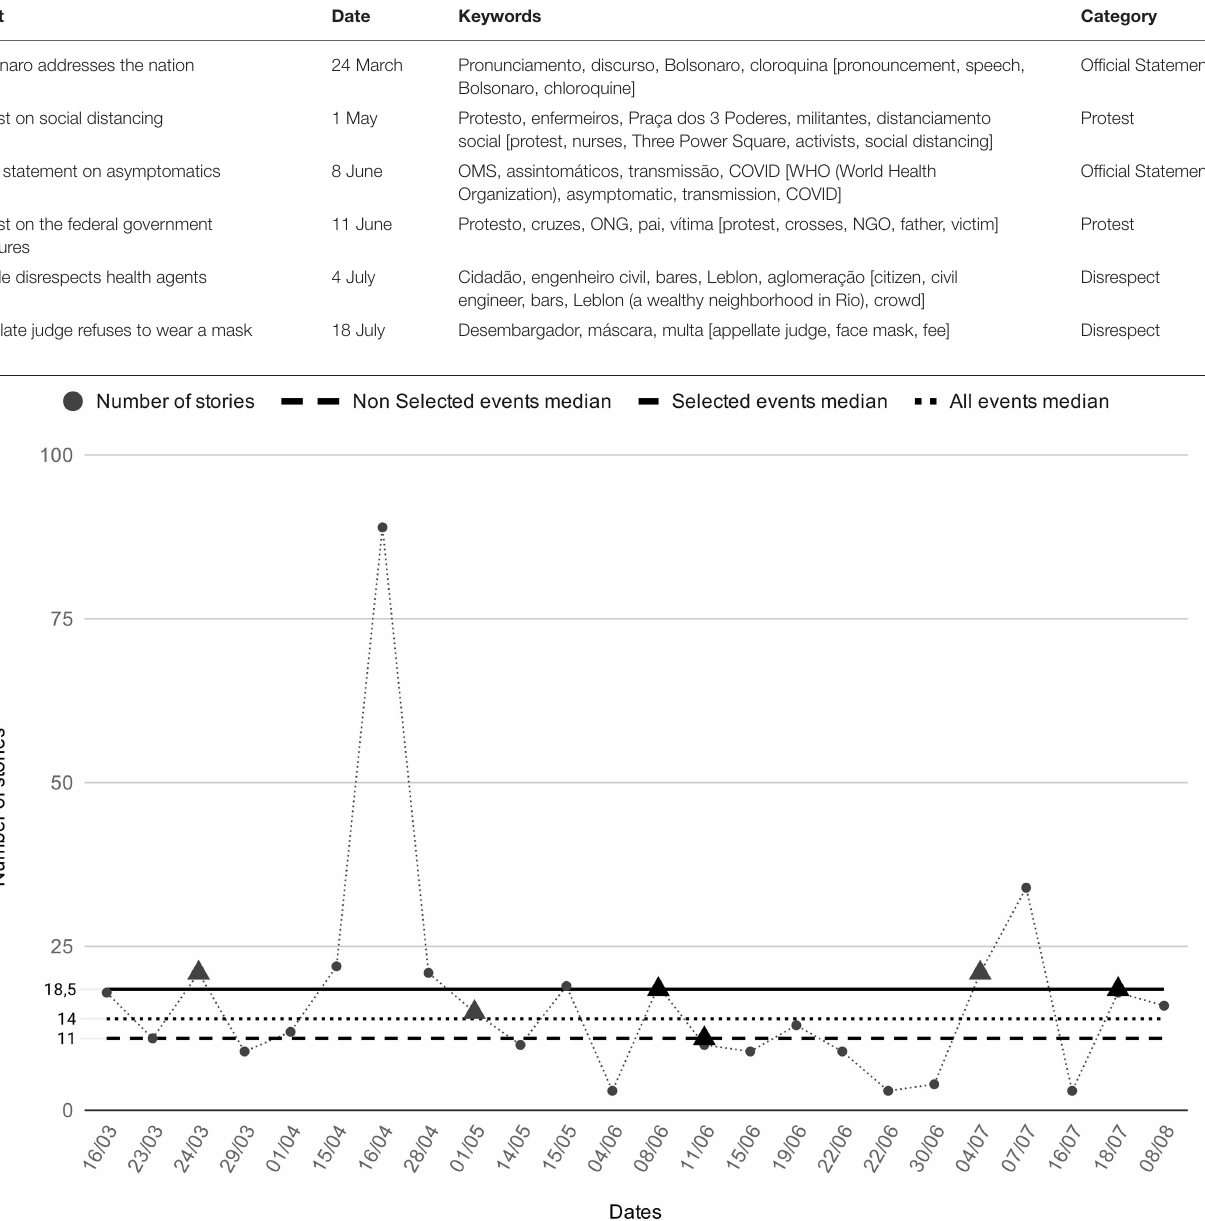
TABLE 1 | Timeline of events selected for analysis.